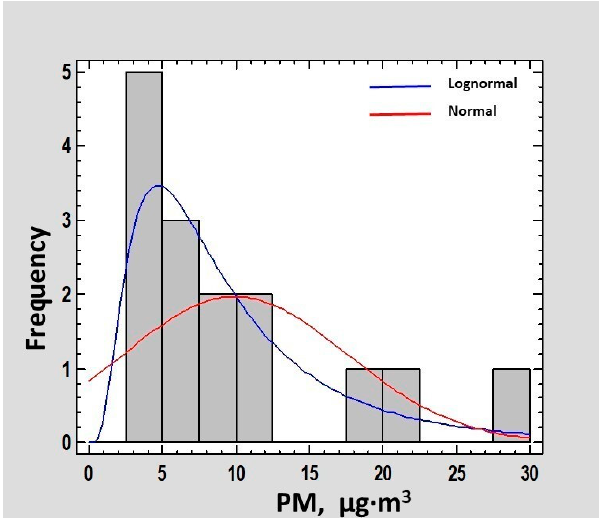
Figure 2. Histogram of normal and lognormal statistical distribution for the total particulate material obtained during the 2016–2017 field campaign. Frequency indicates the number of days. Table 2. P -values obtained for P, K and Cu in PM10 after Kolmogorov–Smirnov test.